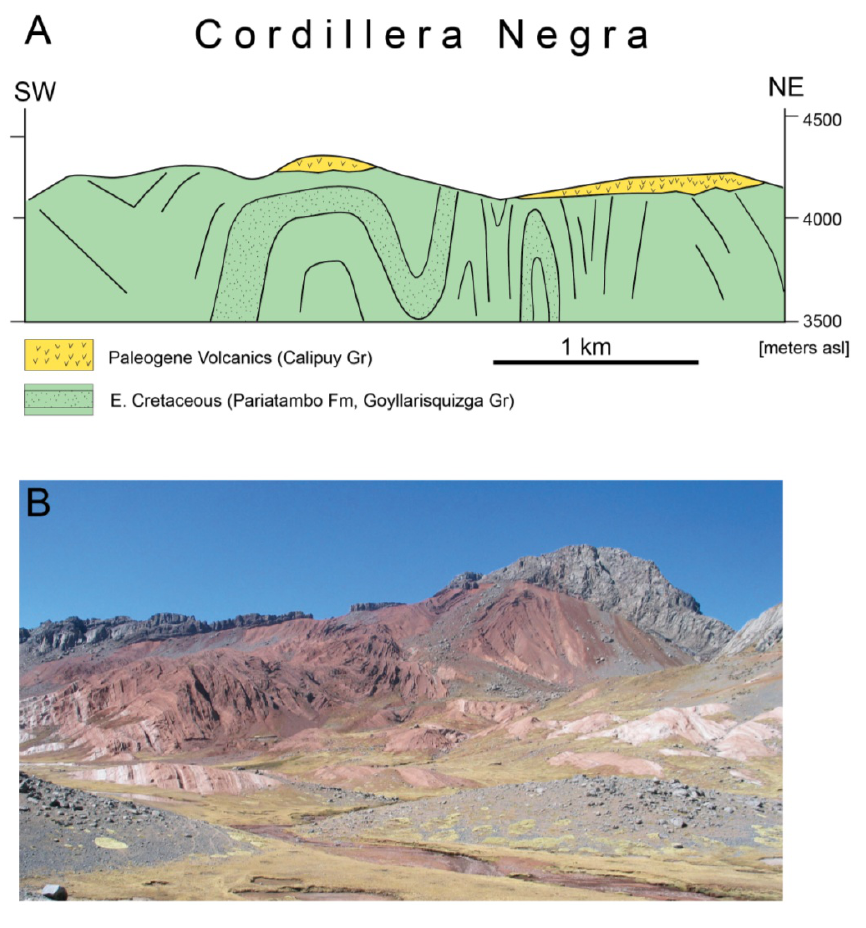
Figure 18. Deformation features linked to the Inca Phase in the Western Cordillera. ( A ) Cross-section in the Cordillera Negra west of Huaraz (see Figure 7 for location). Pre-Cretaceous strata in the Cordillera Negra are nowhere exposed and thus speculative; ( B ) Photograph of the “Great unconformity” at the base of the Calipuy Group in the Cerro Patille (12°27' W, 75°40' W) SE of Laraos. Looking SE; width of photograph ca. 2